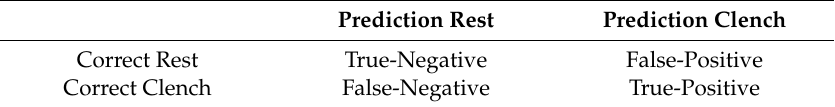
identified as “tooth clenching” using rest-period